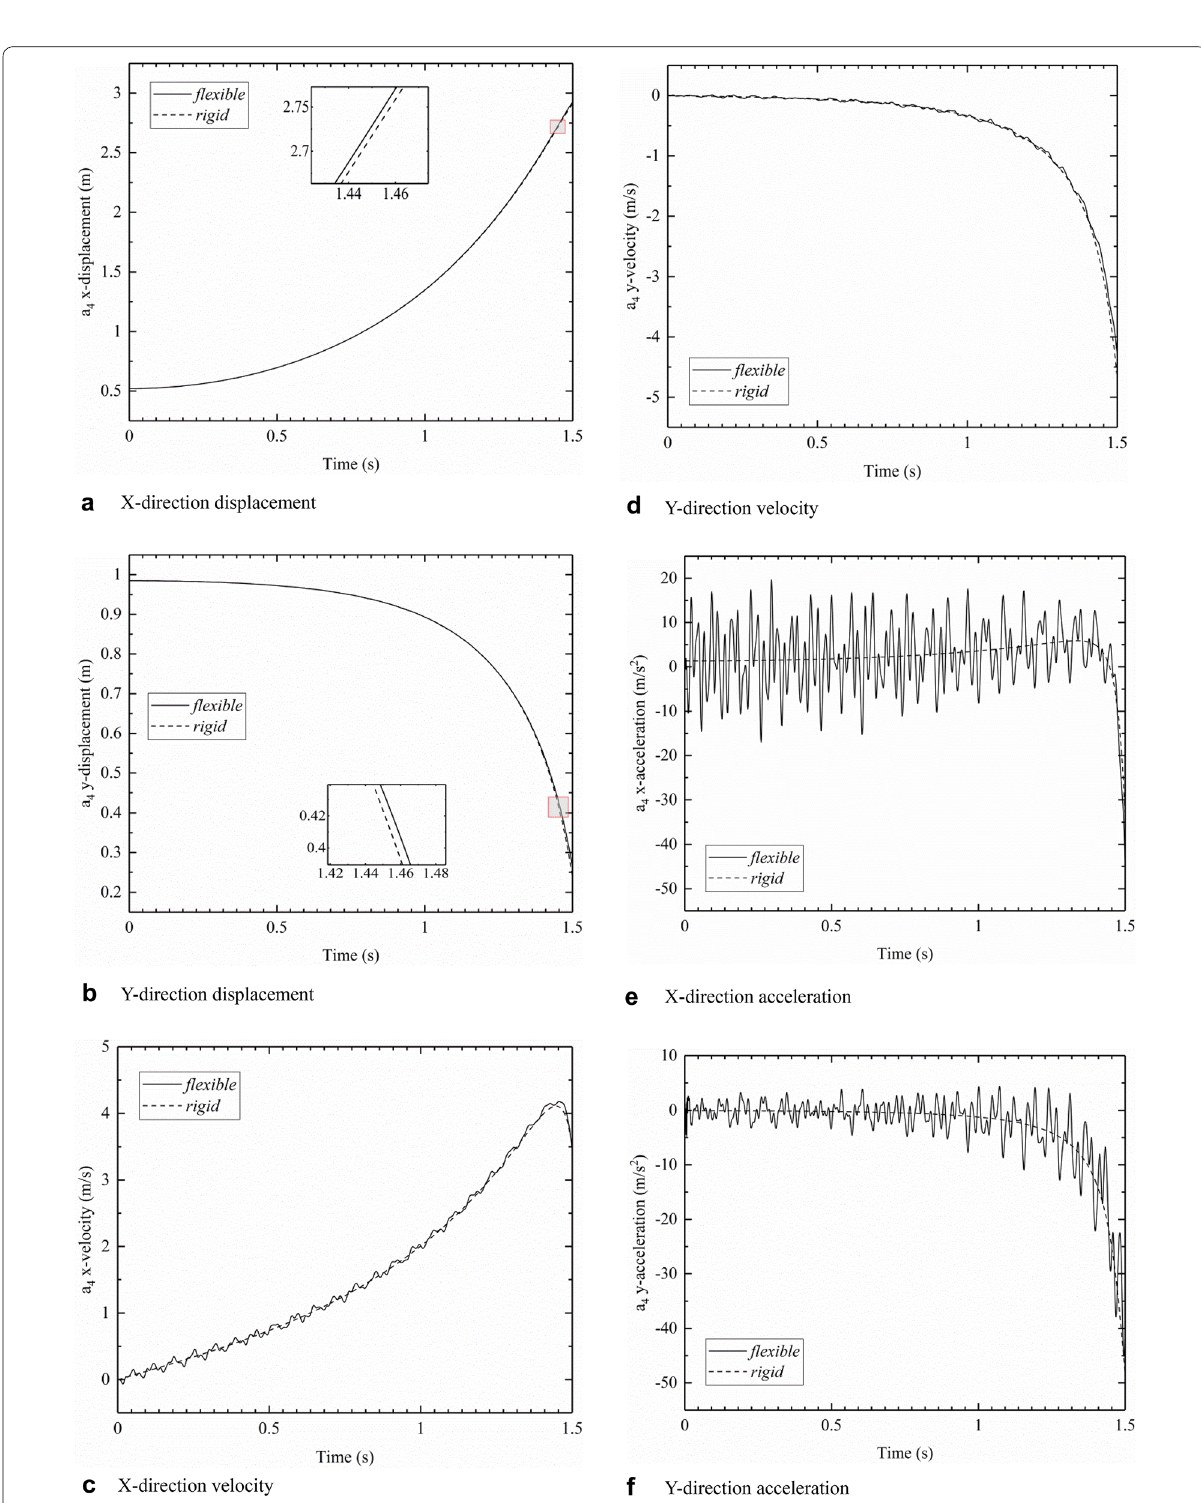
Figure 7 Differences between flexible and rigid kinematical